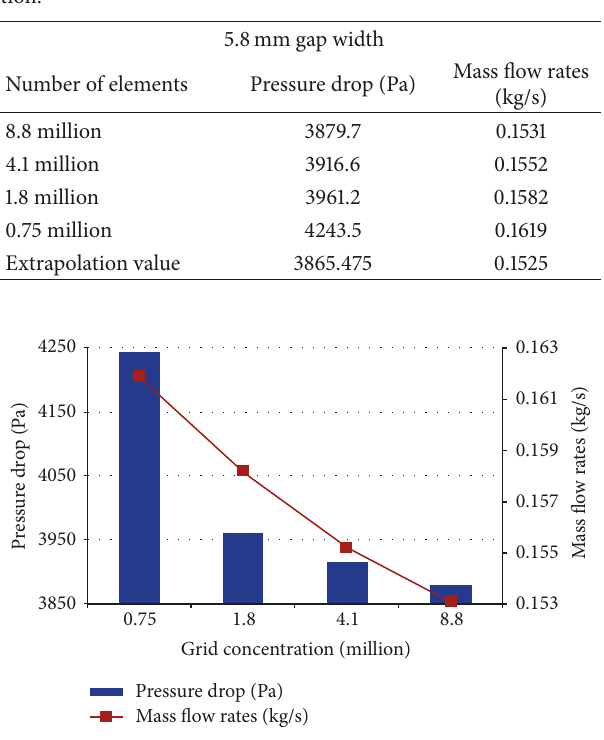
Table 1: Mass flow rates and pressure drop versus grid concentra- tion.